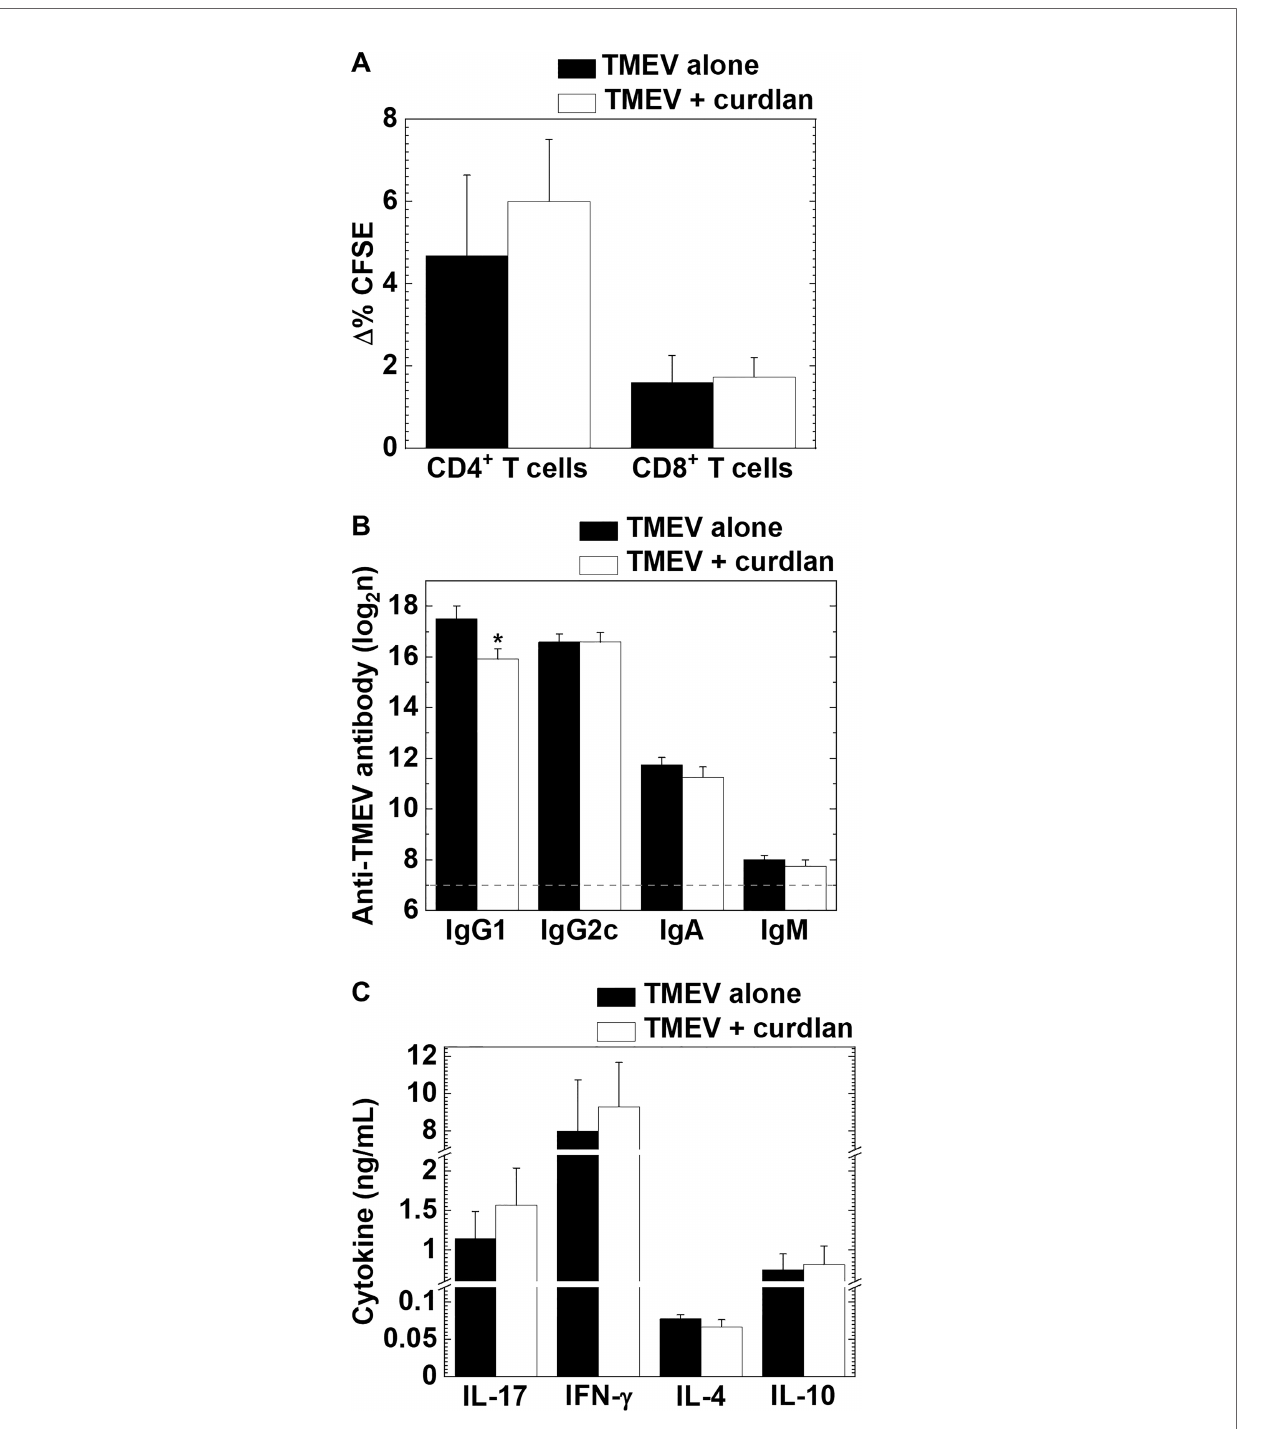
FIGURE 6 | TMEV-speci fi c T cell proliferation and antibody responses, and cytokine productions in TMEV-IDD with or without curdlan treatment. (A) We found similar levels of TMEV-speci fi c CD4 + T cell and CD8 + T cells responses between the control (TMEV alone, black bar) and curdlan-treated (TMEV/curdlan, white bar) mice 5 – 6 weeks p.i. Values of TMEV-speci fi c lymphoproliferative responses were expressed as D % CFSE: (mean CFSE-positive cell % in TMEV-APC stimulation) − (mean CFSE-positive cell % in control-APC stimulation). (B) Although the curdlan treated group had lower serum anti-TMEV IgG1 titers compared with the control group, anti-TMEV IgG2c, IgA, and IgM titers were similar between the two groups 5 – 6 weeks p.i. The dotted line indicates the detection limit. * P < 0.05, Student ’ s t -test. (C) IL-17, IFN- g , IL-4, and IL-10 production from splenic MNCs of the control and curdlan-treated mice 5 – 6 weeks p.i. Antibody titers and cytokine concentrations were determined by ELISAs. (A – C) Values are the mean + SEM from eight to twelve mice per